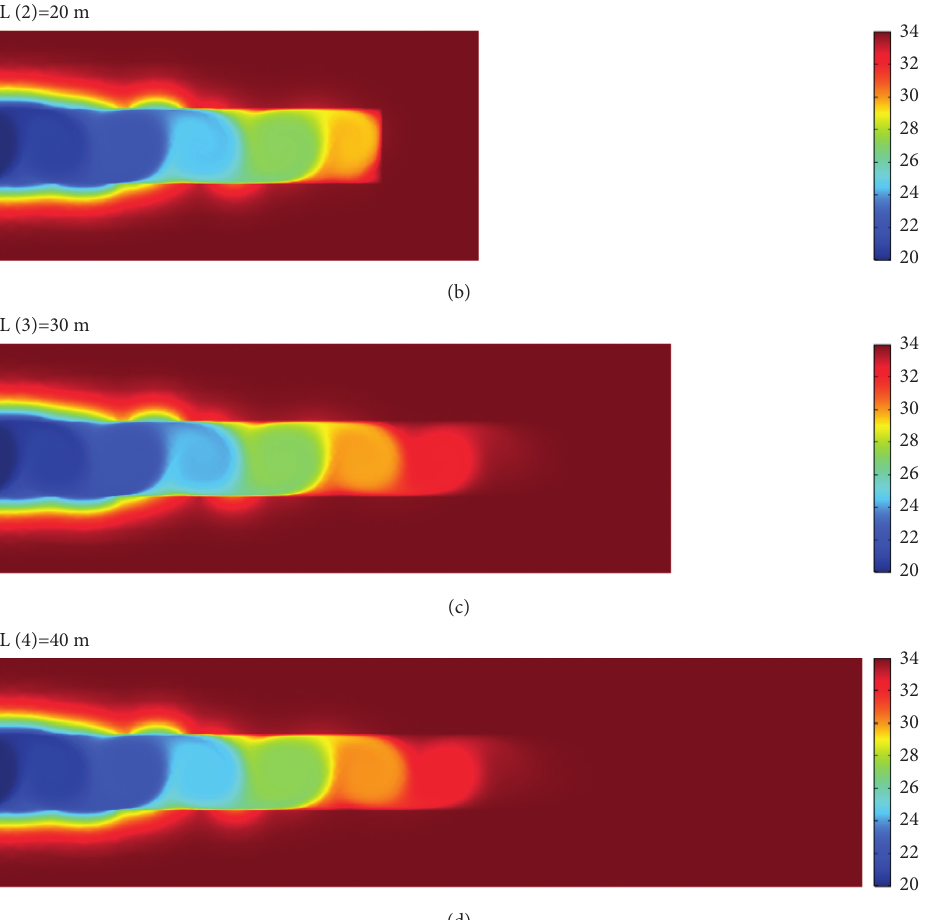
Figure 6: Temperature at different tunnel lengths (10–40m) from the tunnel profile: (a) L (1) � 10m; (b) L (2) � 20m; (c) L (3) � 30m; (d) L (4) � 40m.